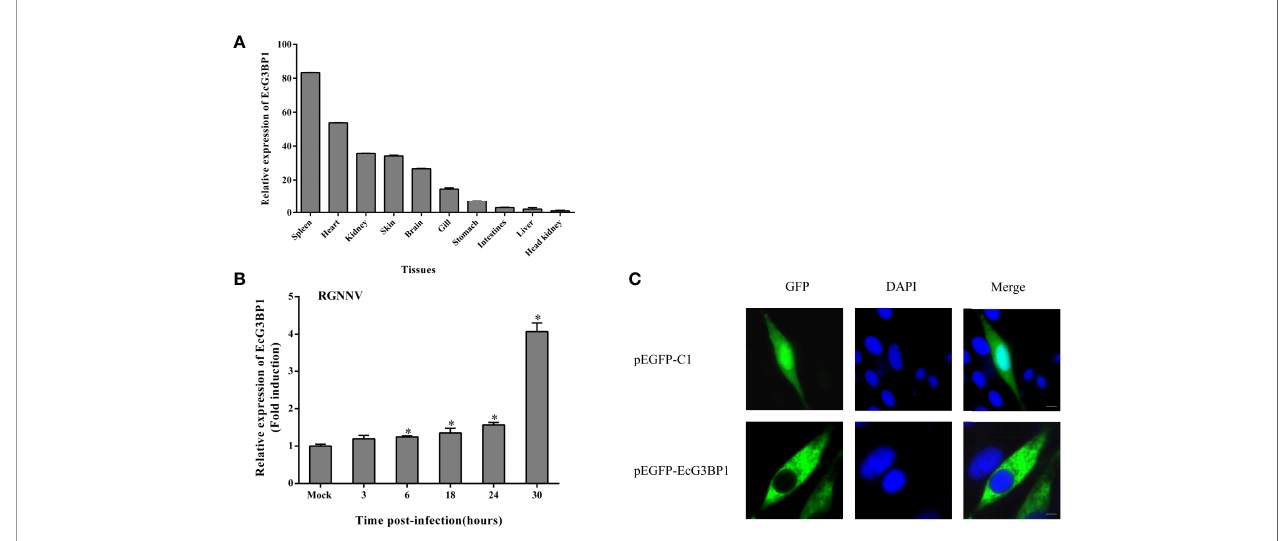
FIGURE 5 | Expression patterns of EcG3BP1. (A) Distribution of EcG3BP1 in tissues of healthy grouper. (B) Changes of EcG3BP1 expression in GS cells infected by RGNNV. (C) The plasmids of pEGFP-C1 and pEGFP-EcG3BP1 were transfected into GS cells and then stained with DAPI. *p <